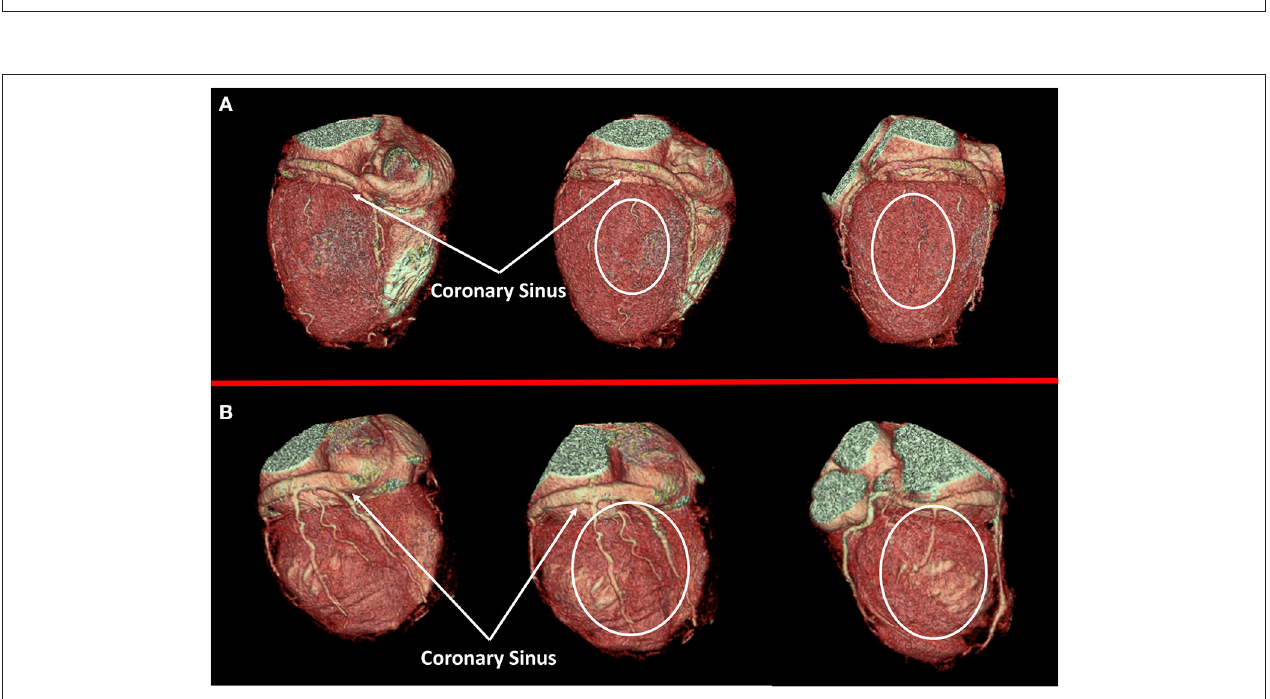
FIGURE 2 | Cardiac veins anatomy evaluation. In (A) a case of dilated cardiomyopathy (DCM) without favorable cardiac vein anatomy for cardiac resynchronization therapy (CRT) implantation is represented; a white circle highlights the absence of adequate cardiac vein on a posterolateral wall. On the contrary, a case of optimal cardiac vein anatomy for CRT implantation is reported in (B)